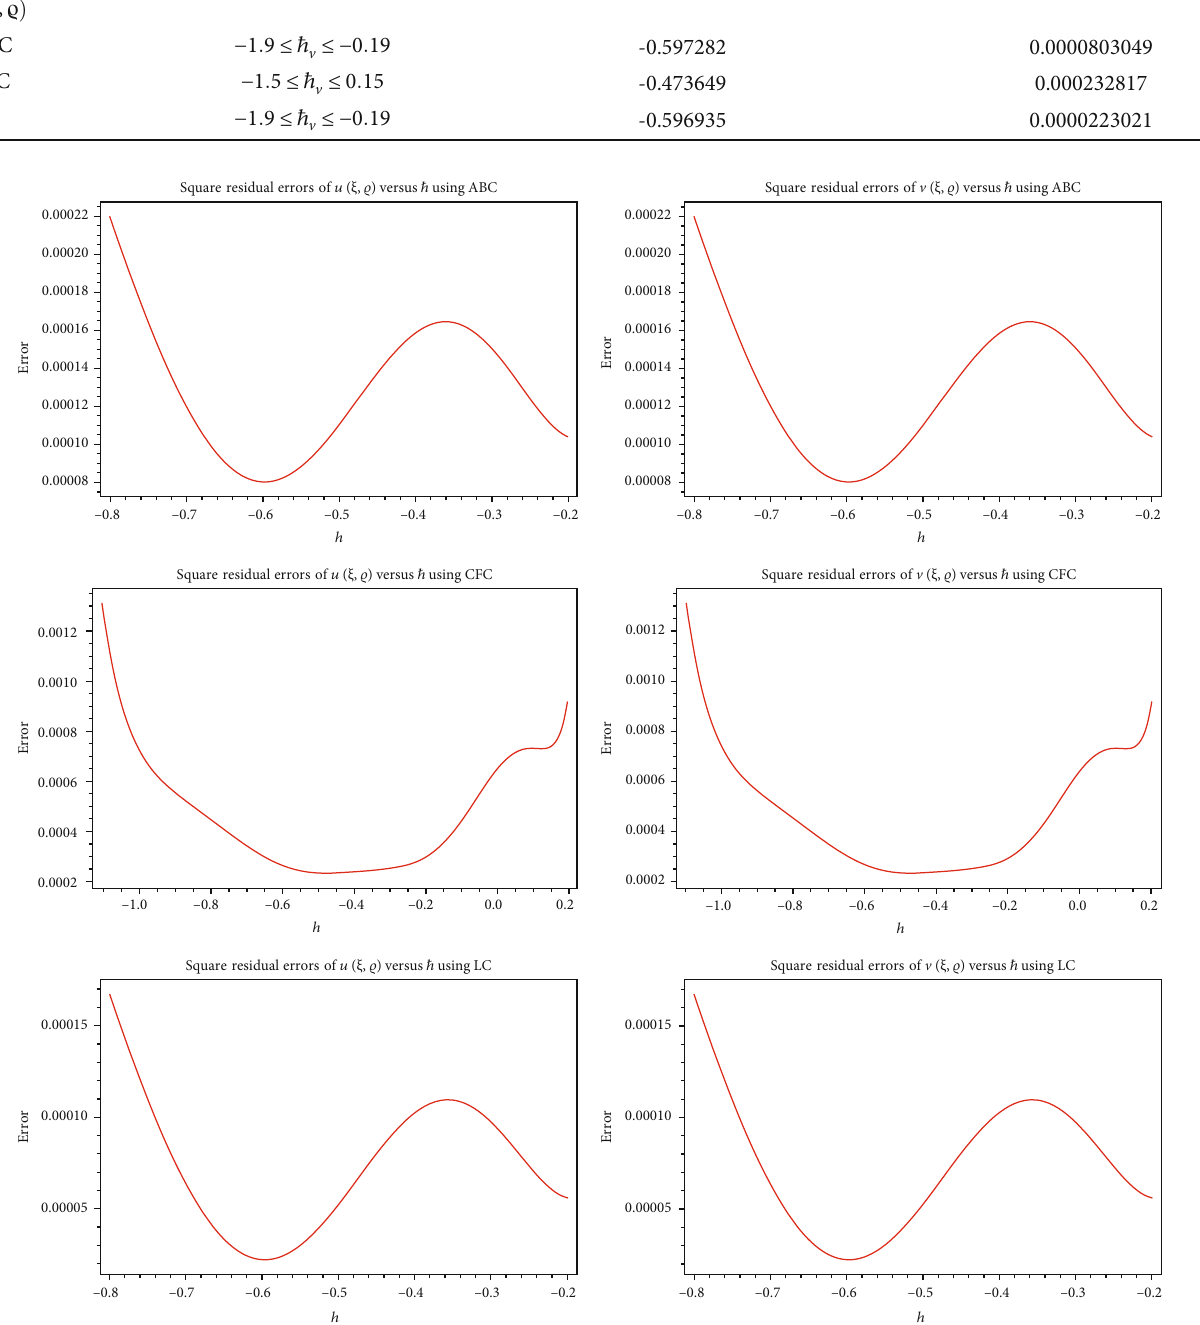
Figure 2: The square residual function Equations (38) and (39) using the third-order approximation solution of the FHATM solutions using the ABC, CFC, and